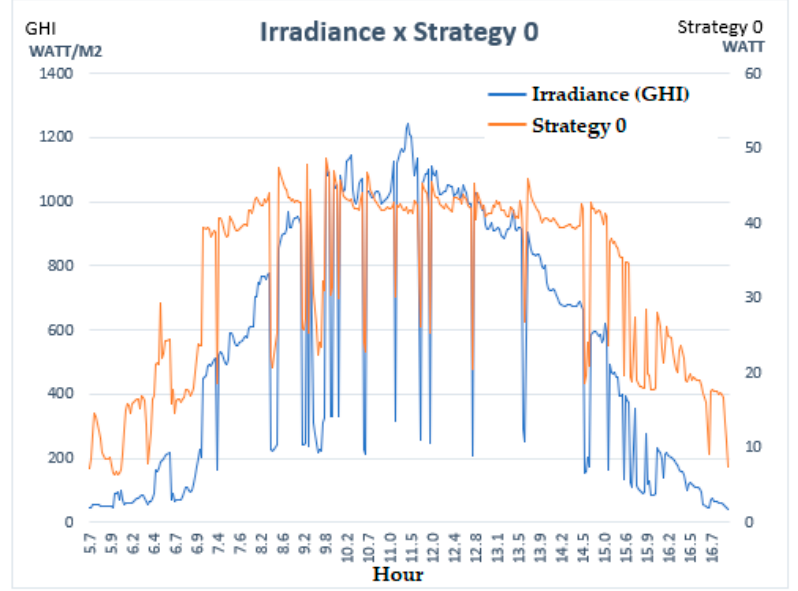
Figure 6. The global horizontal irradiance (GHI) and the correspondence in strategy 0.